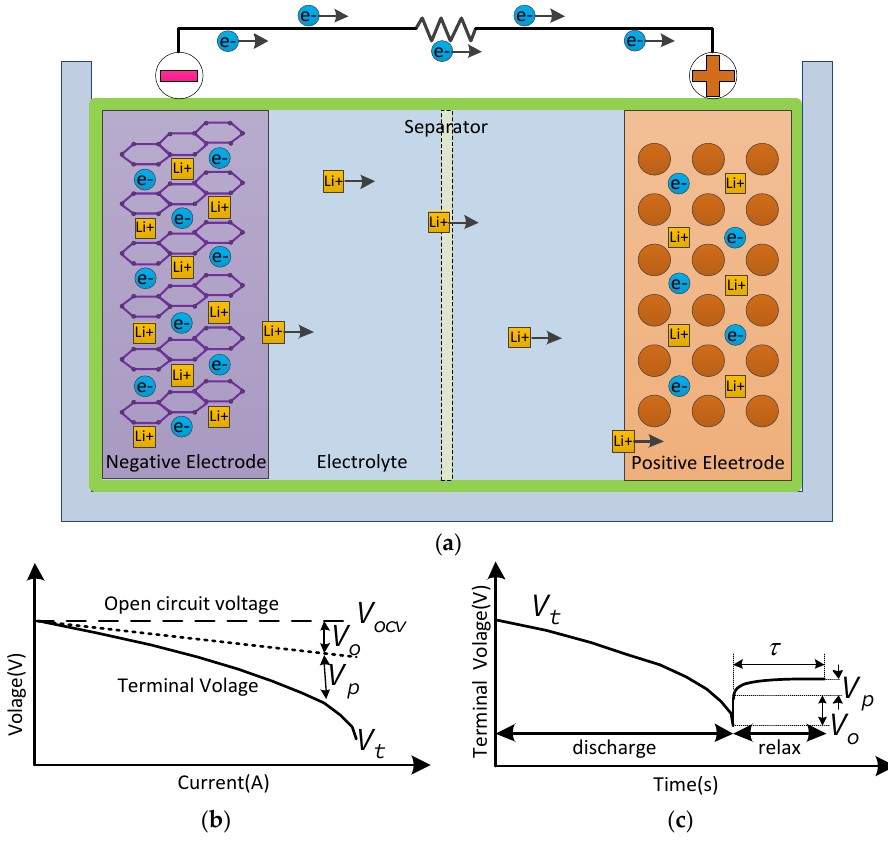
Figure 1. ( a ) The discharge process of a typical lithium-ion battery. ( b ) open-circuit voltage (OCV), ohmic resistance voltage, and polarization voltage as functions of discharge current. ( c ) The relaxation process of the lithium-ion battery, where τ is the relaxation